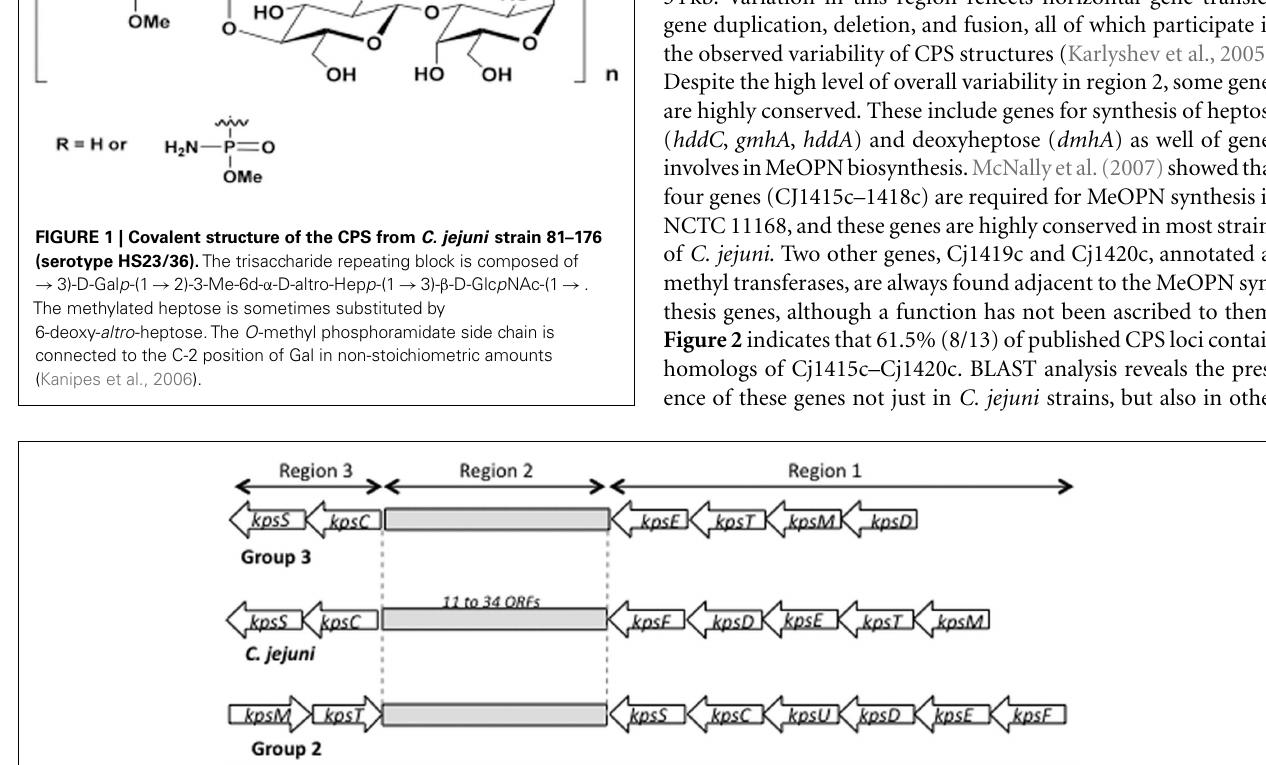
Frontiers in Cellular and Infection